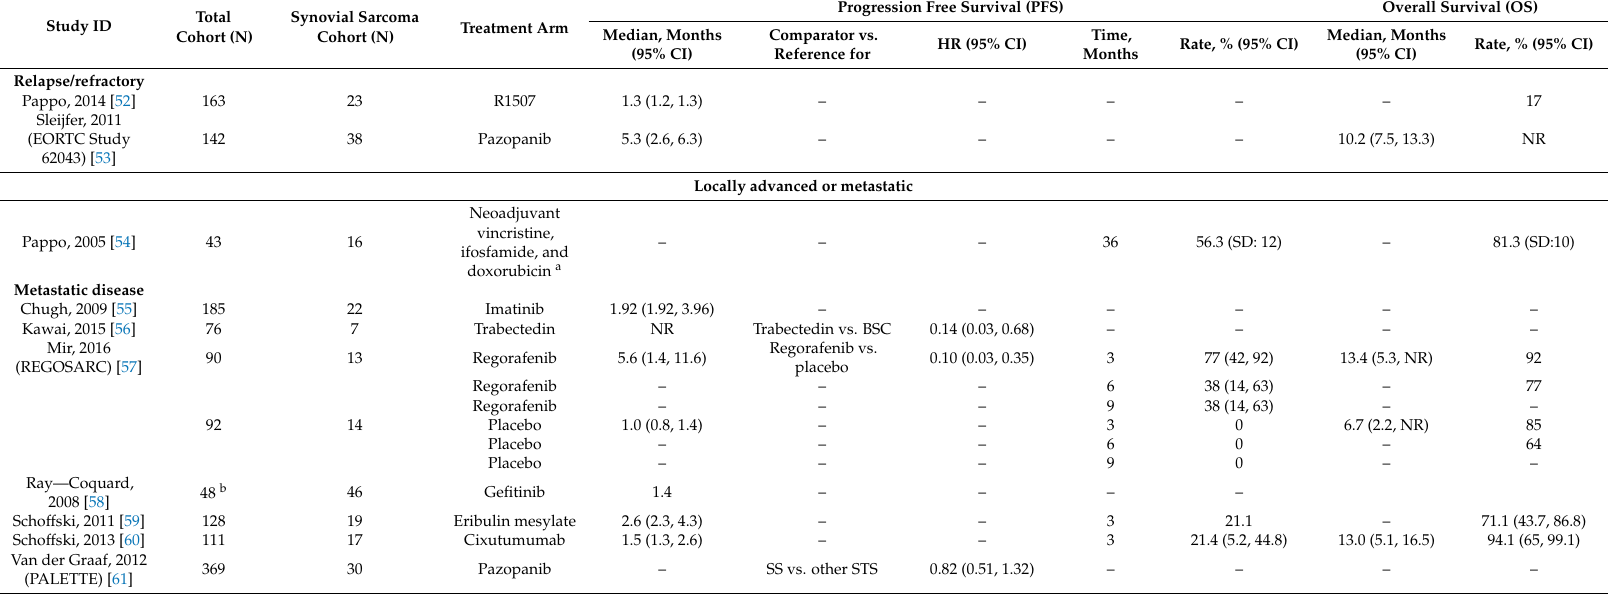
Table 5. SS specific PFS and OS data from prospective studies with a cohort <50